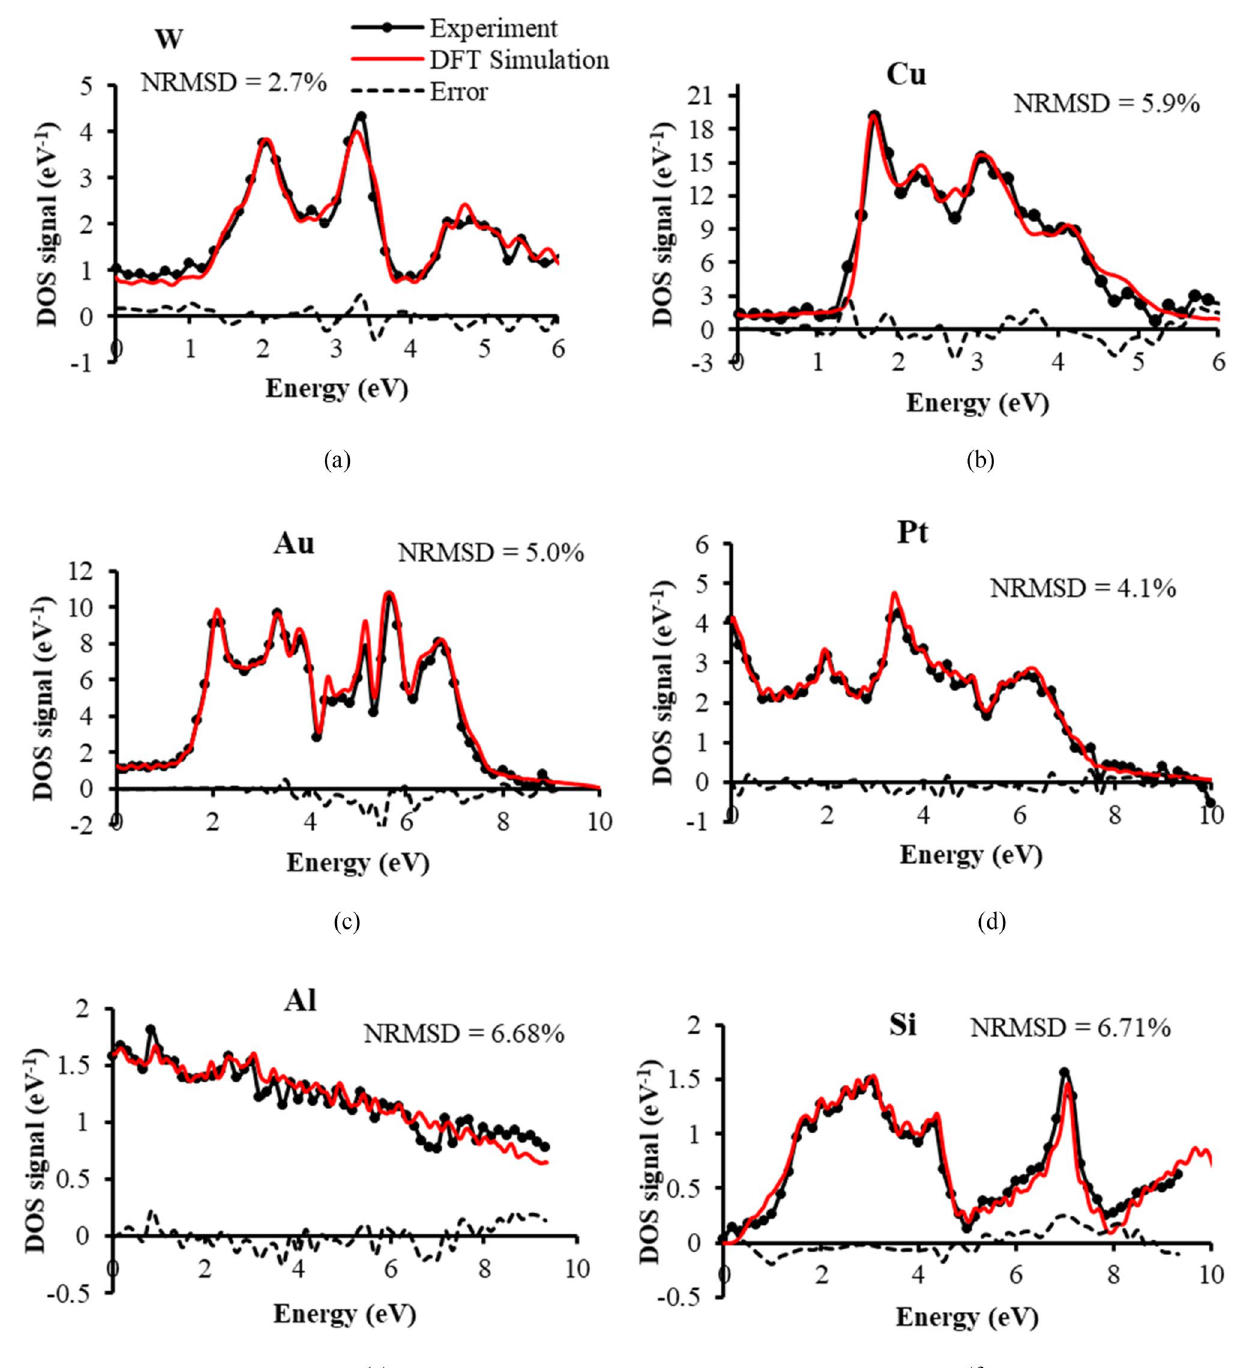
Figure 4. Comparison of SE spectral experimental DOS signals with theoretical DFT distributions and their error signals for 6 test specimens. The independent variable (“Energy”) is labelled as defined by DFT distributions, but experimentally corresponds to SE energy. The experimental SE spectral DOS signal is obtained by numerically differentiating the difference signals shown in Fig. 3. The NRSMD (normalised root mean square difference) values of the error signals are normalised to the experimental DOS signal peak value: ( a ) W ( b ) Cu ( c ) Au ( d ) Pt ( e ) Al ( f ) intrinsic